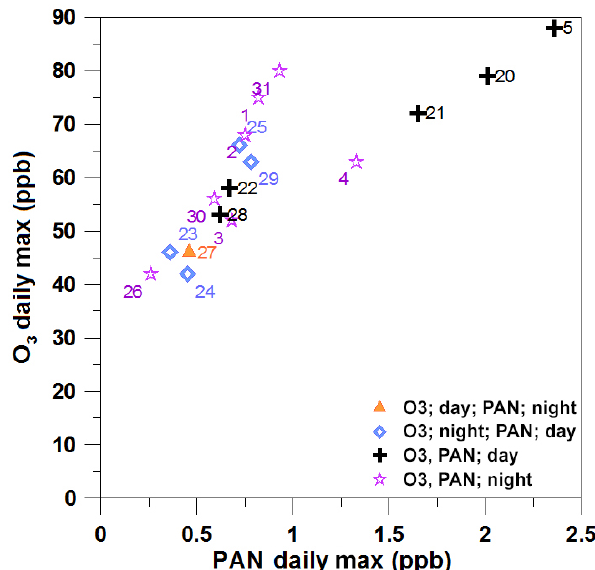
Figure 3. Comparison of O 3 with the PAN daily maxima. The time when the daily maximum appears is classified as daytime (08:00– 18:00) and nighttime (the rest) based on the time of sunrise and sunset. Numerals indicate the